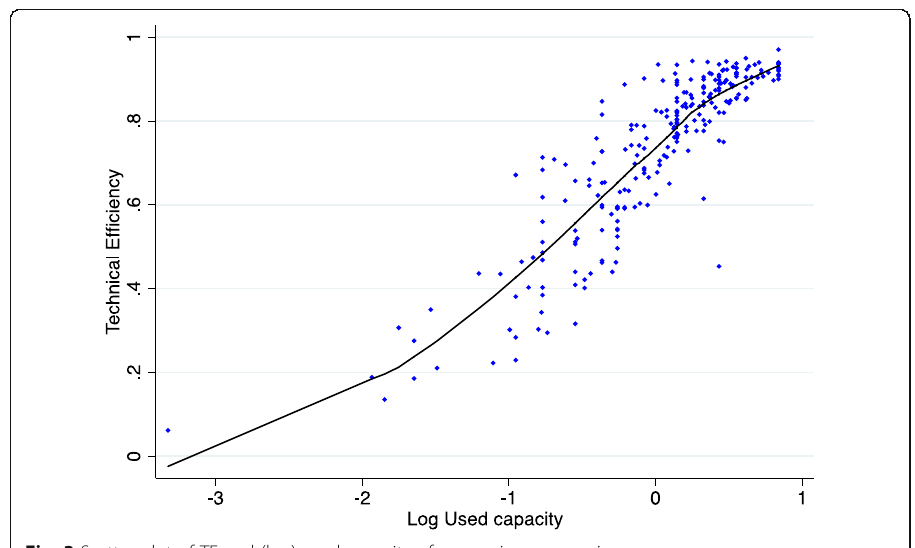
Fig. 3 Scatter plot of TE and (log) used capacity of processing